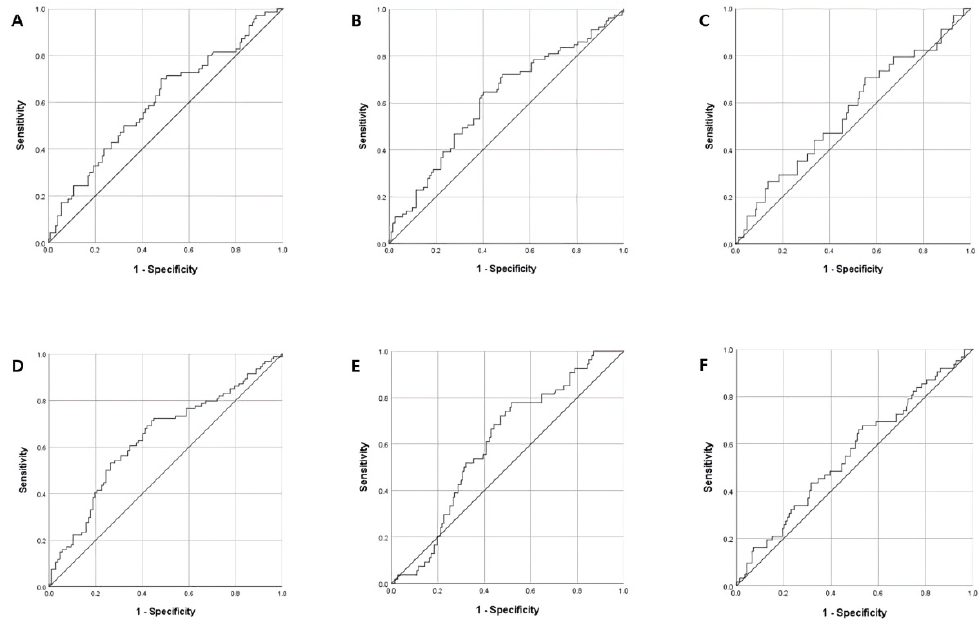
Figure 2. Receiver operating characteristic curve analyses of the associations of NLR with stroke severity and functional outcomes. ( A ) NIHSS (AUC: 0.61, p = 0.014), ( B ) BBS (AUC: 0.61, p = 0.007),